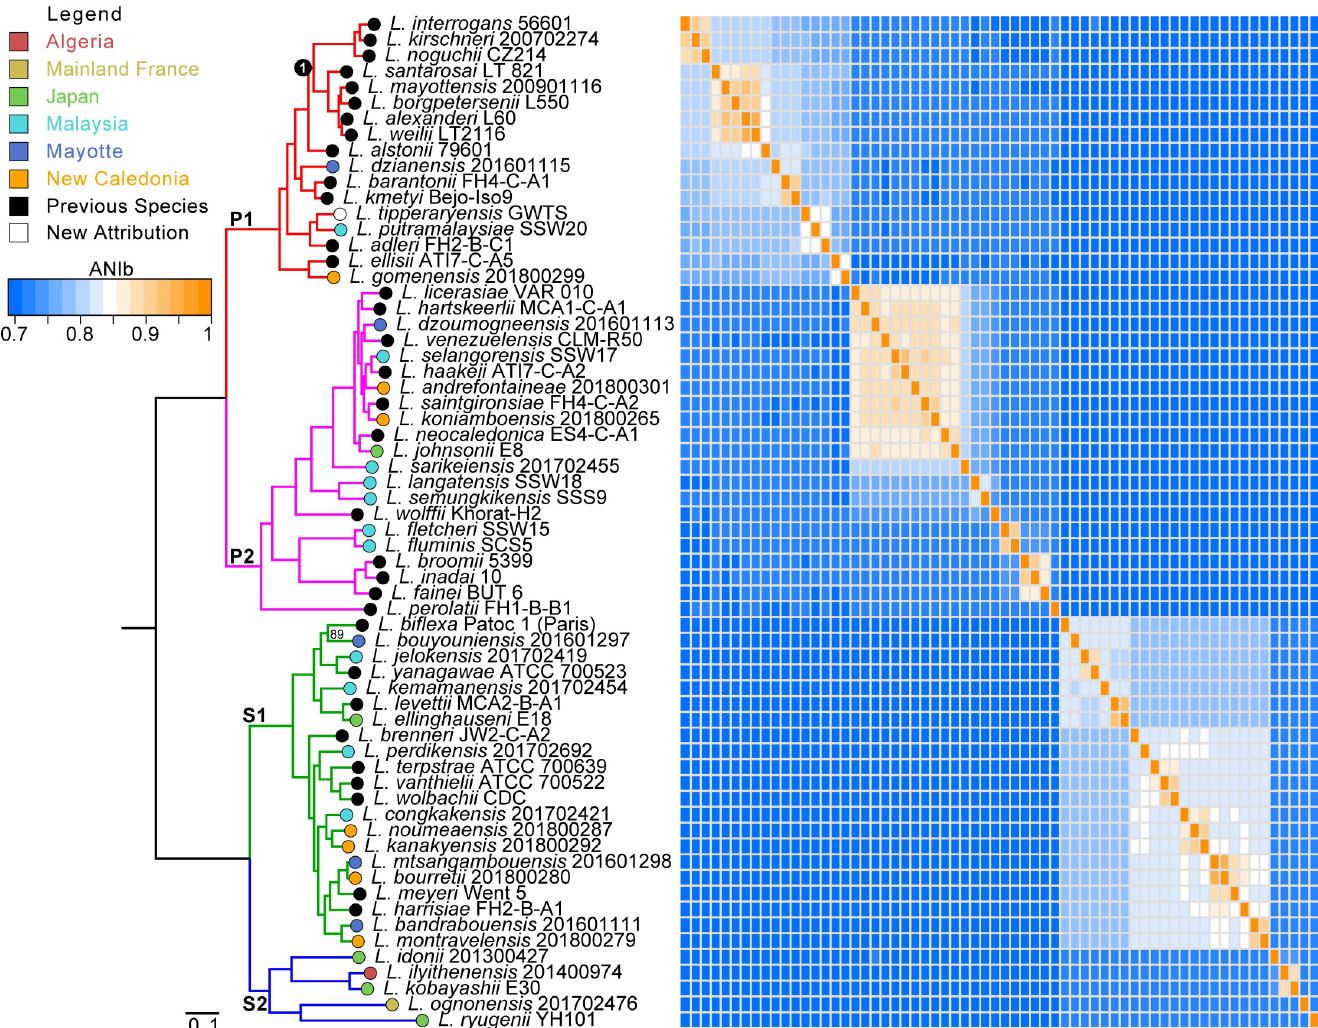
Fig 1. Phylogenetic tree based on the sequences of 1371 genes inferred as orthologous. The matrix represents the calculated ANIb values for all the genomic sequences. The branches are colored according to their belonging to the four main subclades: P1 (red), P2 (purple), S1 (green) and S2 (blue). The bootstrap value is indicated for a single node (that corresponding to the separation between L . biflexa strain Patoc1 and L . bouyouniensis strain 201601297) since all the others have the maximum value of 100. A circle of color, according to the legend, represents the geographical origin of each of the new species described by this study. Node 1 indicates the node from which descent pathogenic species most frequently involved in human